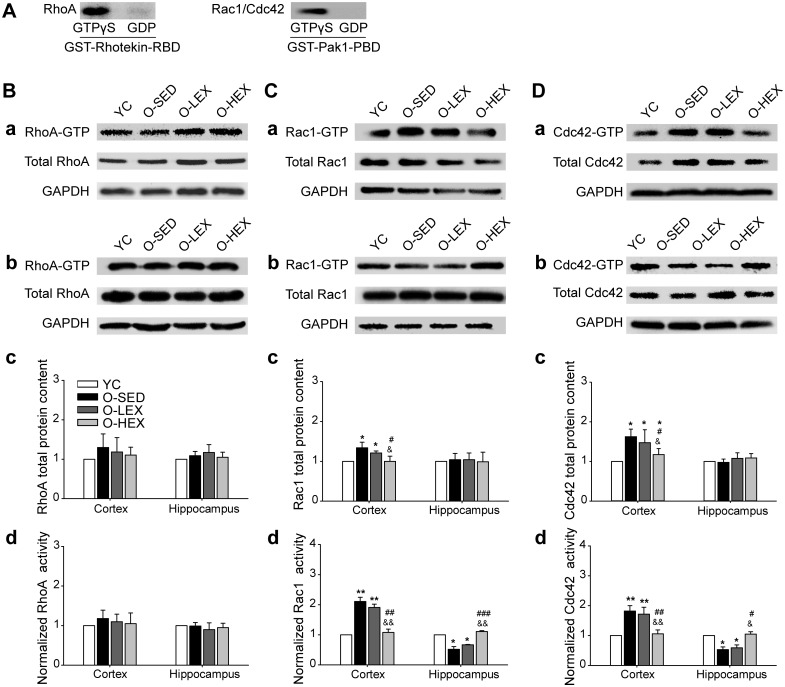
Exercise regulated the expressions and activities of Rho GTPases in the cortex and hippocampus in aging rats.(A) Positive and negative controls of Rho GTPasee in pull down assays. (B) Effects of exercise on the expressions and activities of RhoA. (a-b) Immunoreactive bands corresponding to RhoA active and total protein and GAPDH in the cortex (a) and the hippocampus (b). (c-d) Summarized data of RhoA total protein levels (c, as a ratio to GAPDH) and activities (d, as a ratio to total protein) in the cortex and the hippocampus. n = 5 in each group. (C) Effects of exercise on the expressions and activities of Rac1. (a-b) Immunoreactive bands corresponding to Rac1 active and total protein and GAPDH in the cortex (a) and the hippocampus (b). (c-d) Summarized data of Rac1 total protein levels (c, as a ratio to GAPDH) and activities (d, as a ratio to total protein) in the cortex and the hippocampus. n = 5 in each group. (D) Effects of exercise on the expressions and activities of Cdc42. (a-b) Immunoreactive bands corresponding to Cdc42 active and total protein and GAPDH in the cortex (a) and the hippocampus (b). (c-d) Summarized data of Cdc42 total protein levels (c, as a ratio to GAPDH) and activities (d, as a ratio to total protein) in the cortex and the hippocampus. Values are mean and standard error of the mean, n = 5 in each group. *P< 0.05 vs YC, **P< 0.01 vs YC, #P< 0.05 vs O-SED, ##P< 0.01 vs. O-SED, ### P< 0.001 vs. O-SED, &P< 0.05 vs. O-LEX, &&P < 0.01 vs. O-LEX.